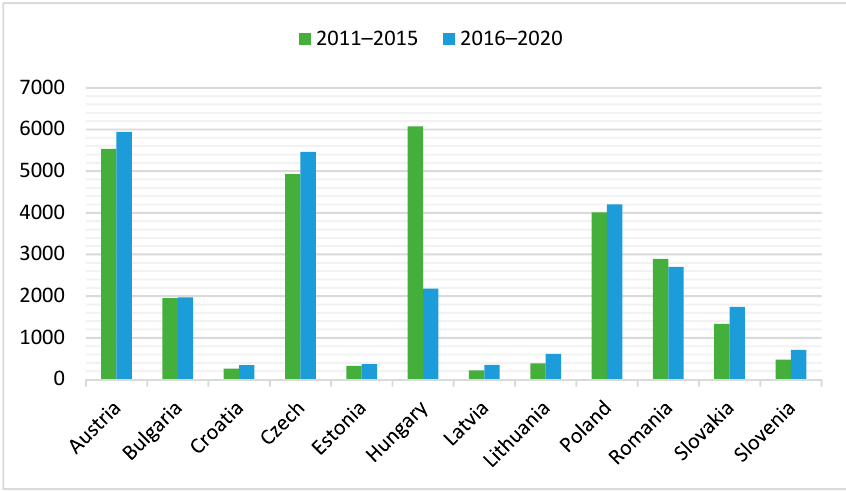
Figure 7. Green trade (USD thousand) in comparison before and after 3SI. Based on MoE data [27].